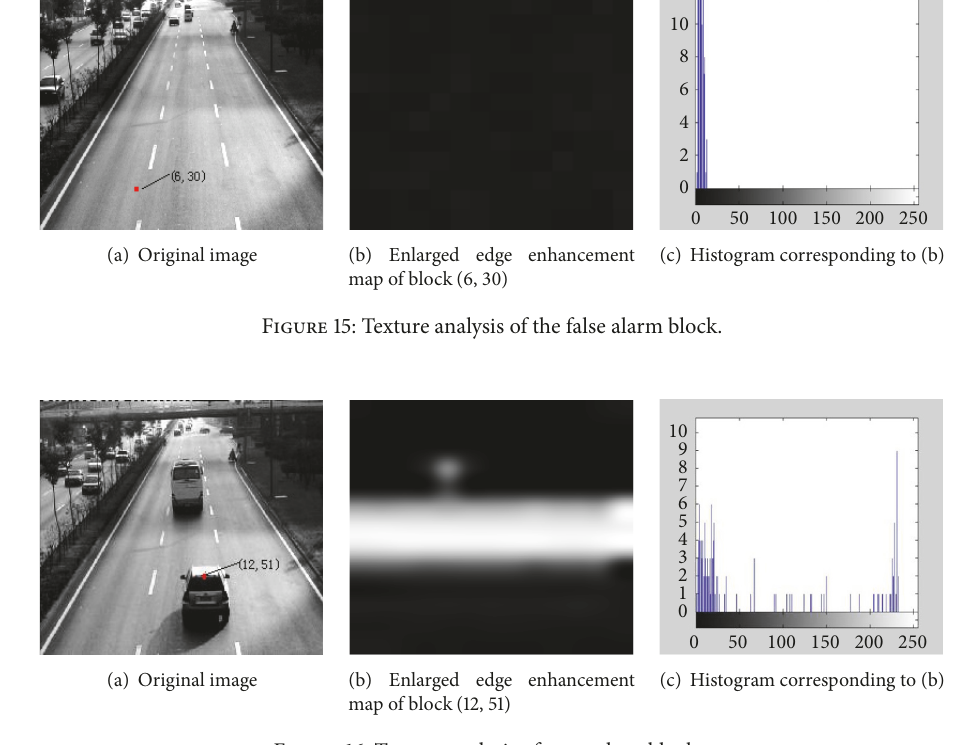
Figure 16: Texture analysis of anomalous